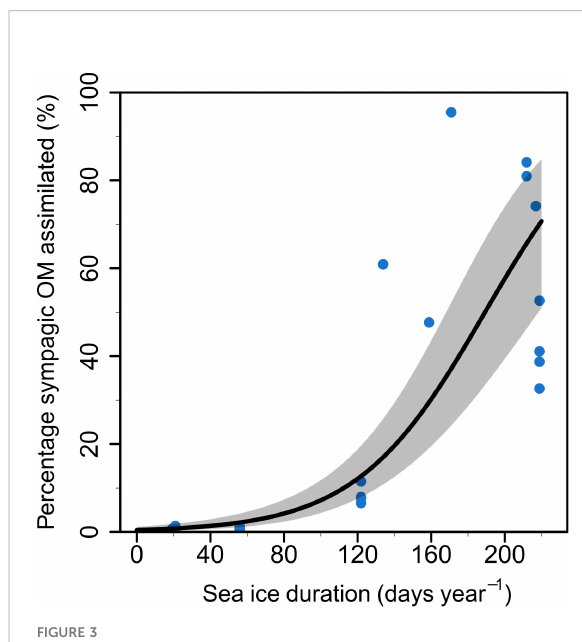
FIGURE 3 Proportion of sympagic organic matter (OM) assimilated based on the H-print approach against sea ice duration at each station for Ctenodiscus crispatus samples. The line represents a regression on logit-transformed data with 95% con fi dence intervals as shaded grey area. Each point represents one